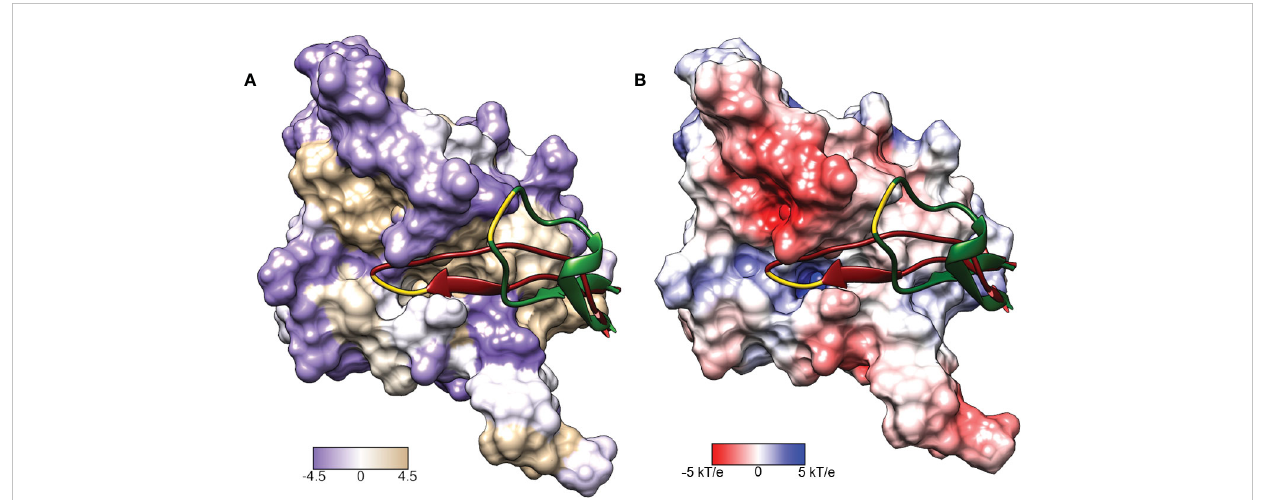
FIGURE 3 Surface representations of the LexA repressor protein. The ribbon represents the CSR in the cleavable (red, PDB: 1JHE) and non-cleavable (green, PDB: 1JHC) forms. The key scissile bond (Ala-84 – Gly-85) is in yellow. (A) depicts the amino acid hydrophobicity using the Kyte-Doolittle scale. (B) illustrates the electrostatic potential (kT/e) of the surface, calculated using DelPhi Webserver (Sarkar et al., 2013). These representations depict the catalytic pocket that the CSR moves into when the protein is activated. As the surface representations indicate, the pocket is highly hydrophobic and electrostatically positive.